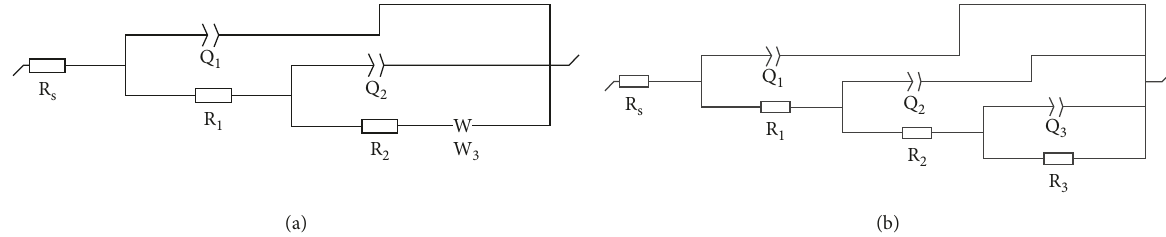
Figure 4: Equivalent circuits used to fit EIS spectra in chloride-added KURTgroundwater solution for (a) SS316L, Ti-Gr.2, and alloy 22, and (b) Cu.